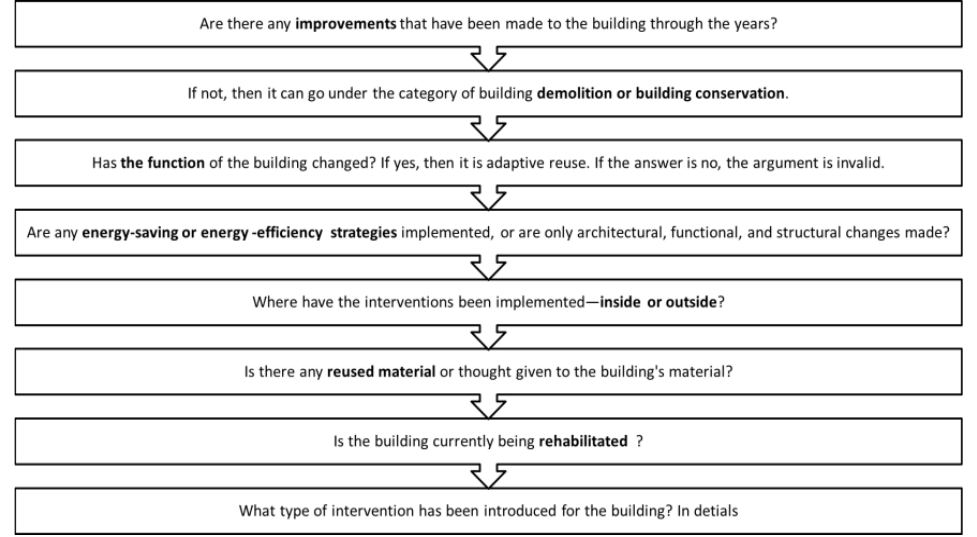
Figure 8. Steps for applying the developed definition framework to the case studies.